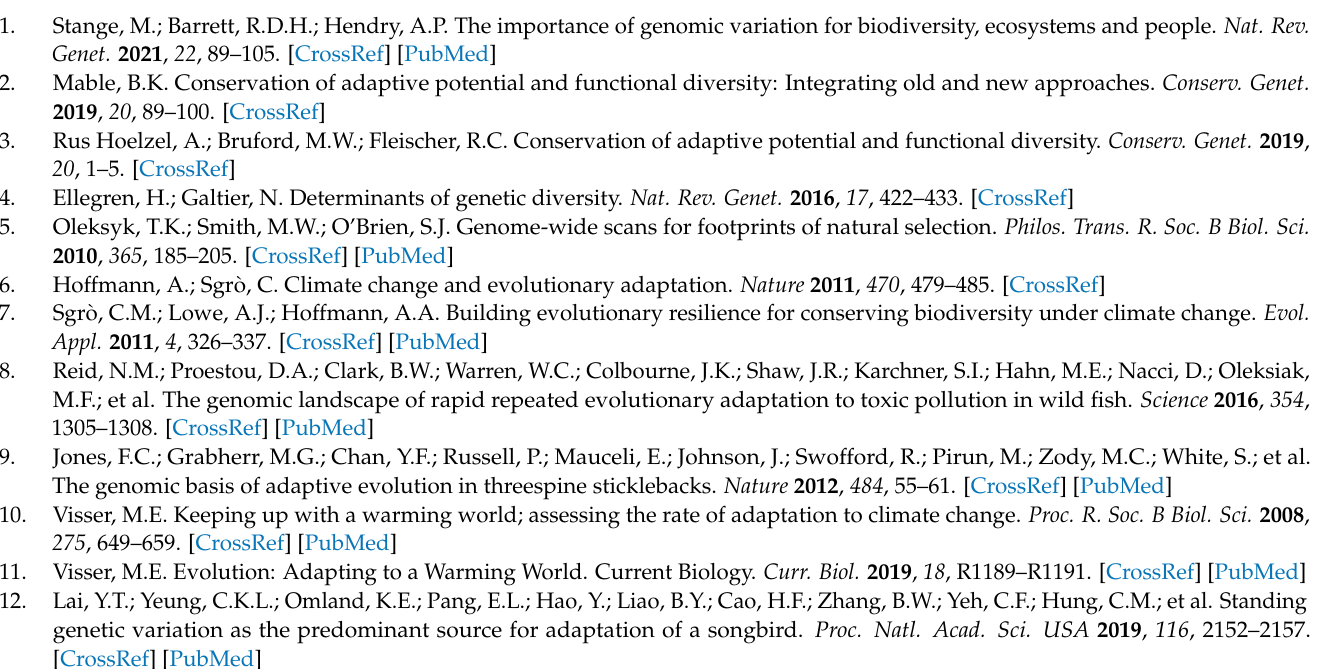
Table S4. C-scaffold IDs from used genome assemblies and their synonyms shown in Figures; Table S5. Coordinates of localized STR loci (L-category) in six mustelid species; Table S6. Coordinates of pseudoautosomal region in eight species